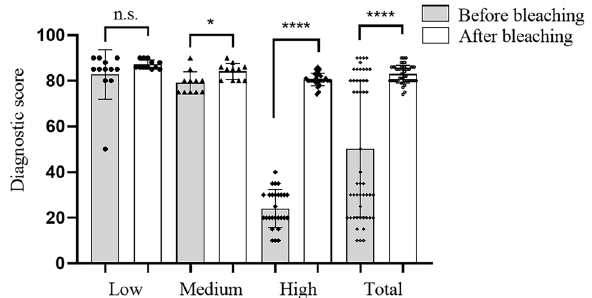
Figure 4. Comparison of diagnostic scores of 50 pathological sections with melanin before and after bleaching, Low, medium and high melanin groups (n = 12, 11, 27). In the low melanin content group (n = 12), there was no difference in the diagnostic value before and after bleaching (P > 0.05); In the medium melanin content group (n = 11), there was difference in the diagnostic value before and after bleaching (*P < 0.05); In the high melanin content group (n = 27), there was difference in the diagnostic value before and after bleaching (****P < 0.0001); The data are presented as the mean ± SD.